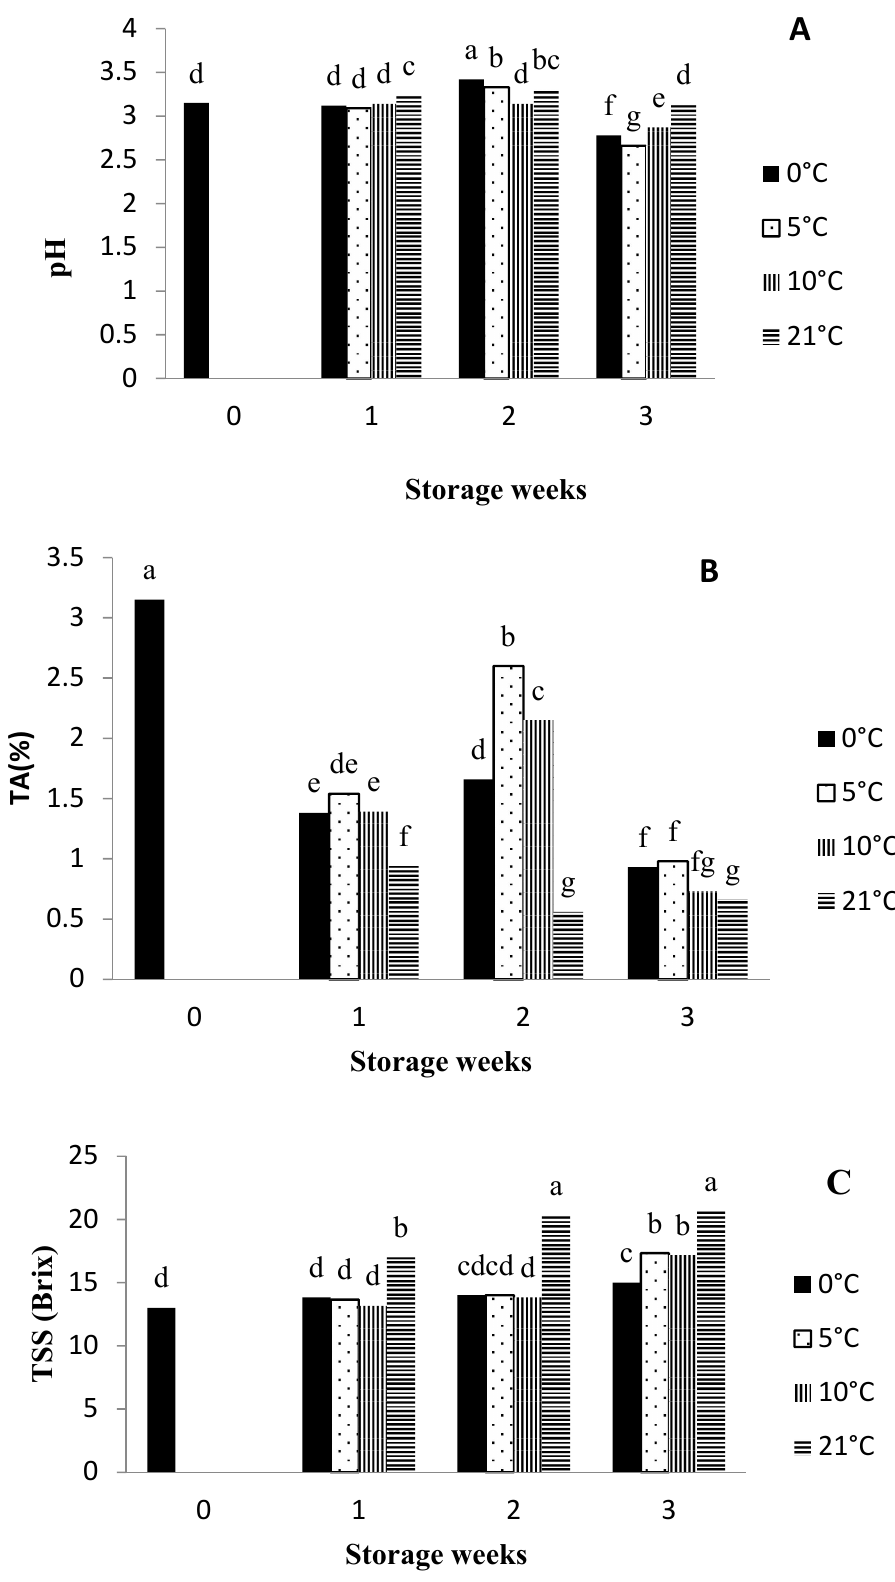
Figure 2. Effects of different storage temperatures on pH ( A ), titratable acidity (TA) ( B ), and total soluble solid (TSS) content ( C ) of cornelian cherry fruits treated with 1% chitosan. Different letters on bars indicate significant differences among storage temperatures at p < 0.01 by Duncan’s test.